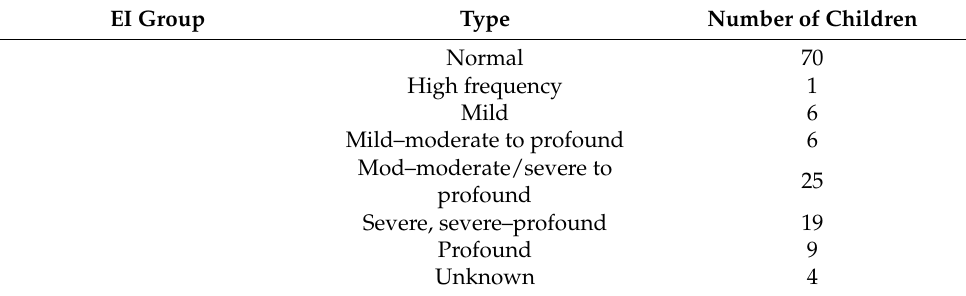
Table 7. Early Intervention (EI) group by level of unilateral hearing loss